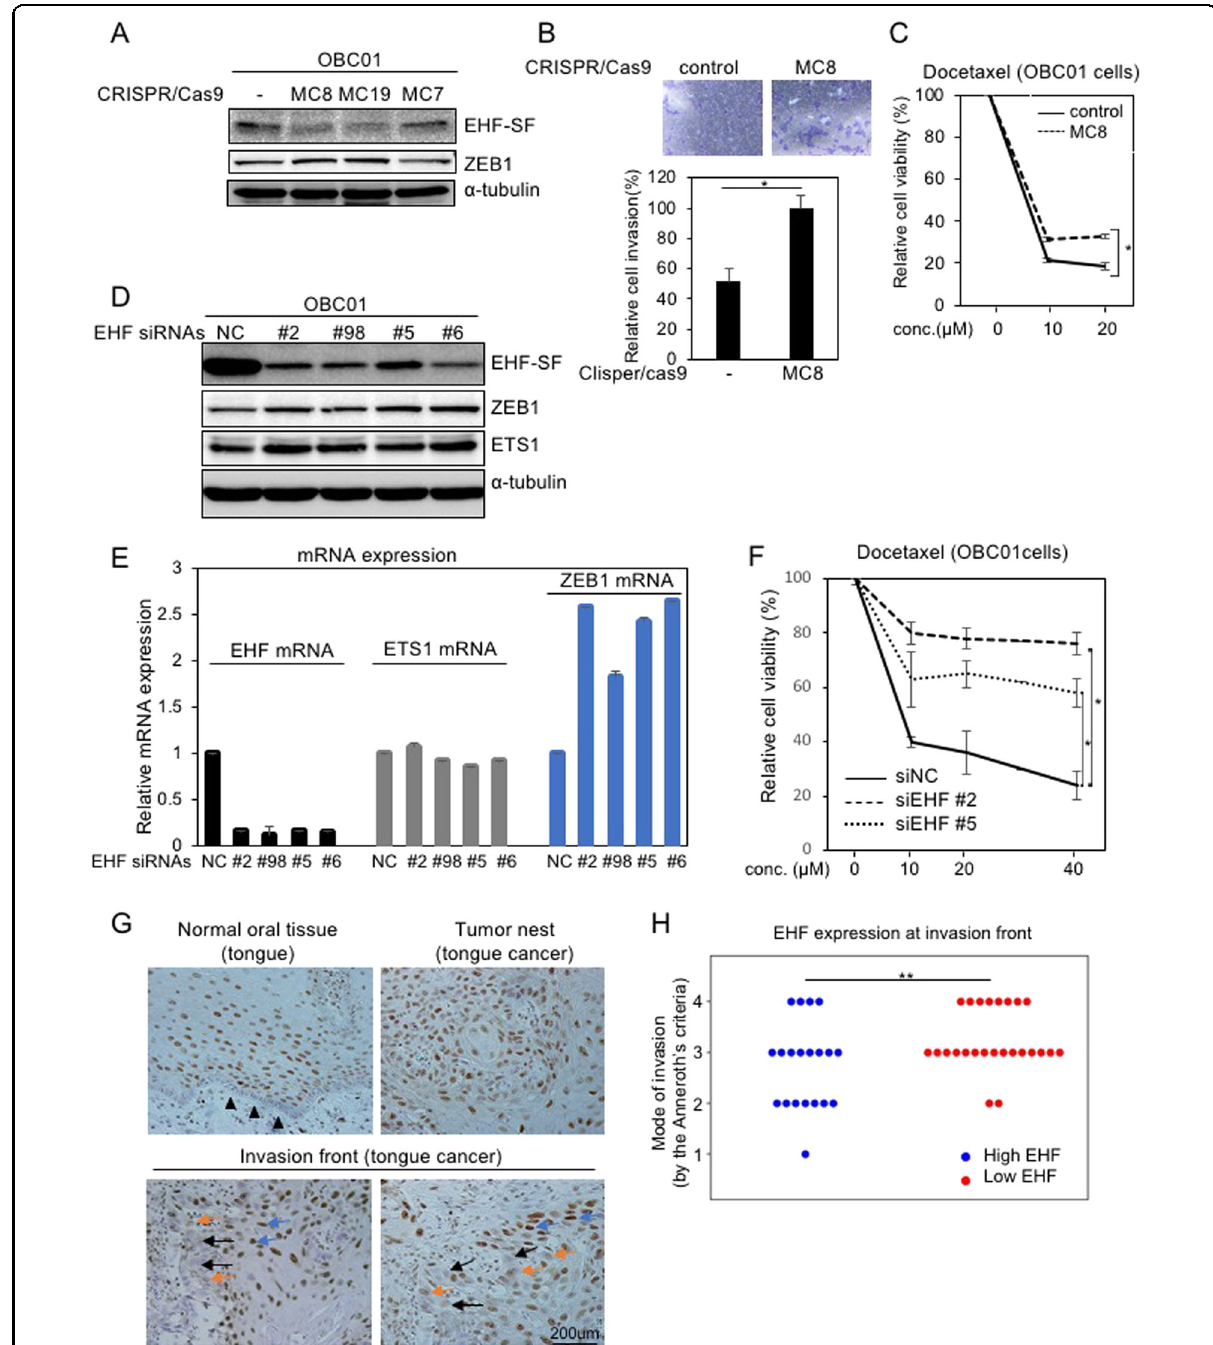
Fig. 5 (See legend on next page.) Identi fi cation of a novel point mutation in the EHF gene in cancer cells When we generated EHF cDNAs using mRNAs isolated from breast cancer cells by RT-PCR in this study, we found that a leucine residue at 285 in EHF was mutated to